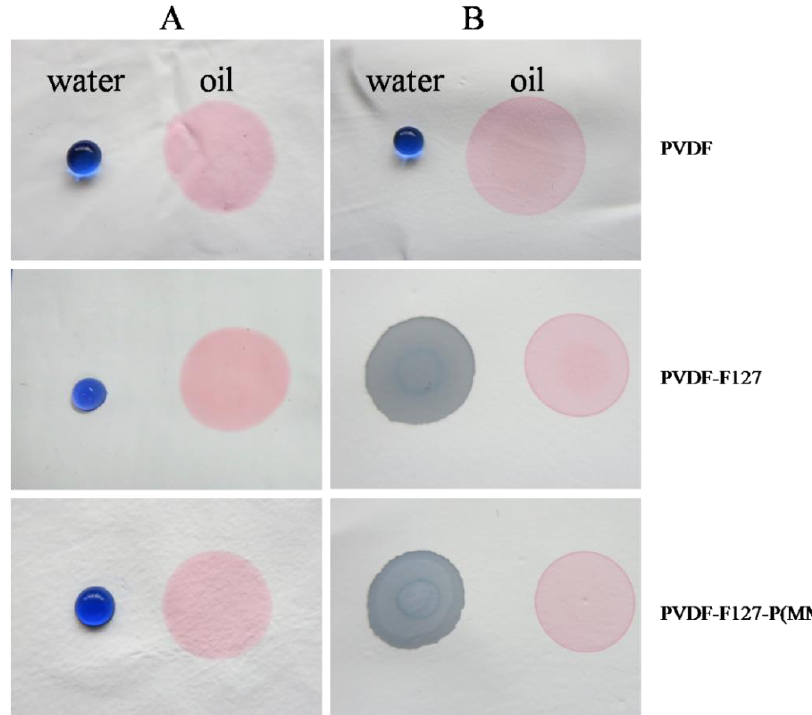
Figure 3. Droplets of water (dyed blue) and n-hexane oil (dyed red) on the PVDF, PVDF-F127, PVDF-F127-P (MMA-AA) membranes: ( A ) without heating treatment, ( B ) via heating treatment, respectively.